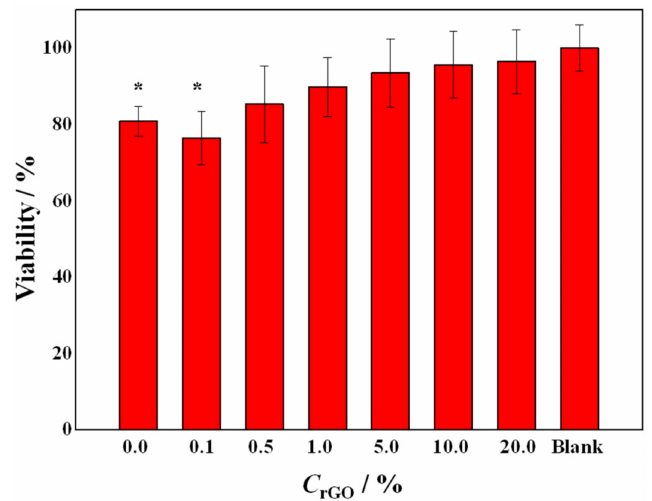
Figure 11. Viability of the cells treated with the liquid extracts from the electrospun samples with different rGO concentrations. The asterisk (*) represents a statistically significant difference ( p < 0.01) relative to the untreated cells. The error bars present the standard deviation ( n =